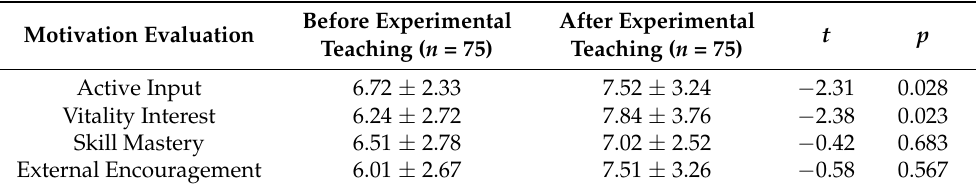
Table 6. Comparison of Motivation Evaluation Variables of CG before and after Experimental Teaching.